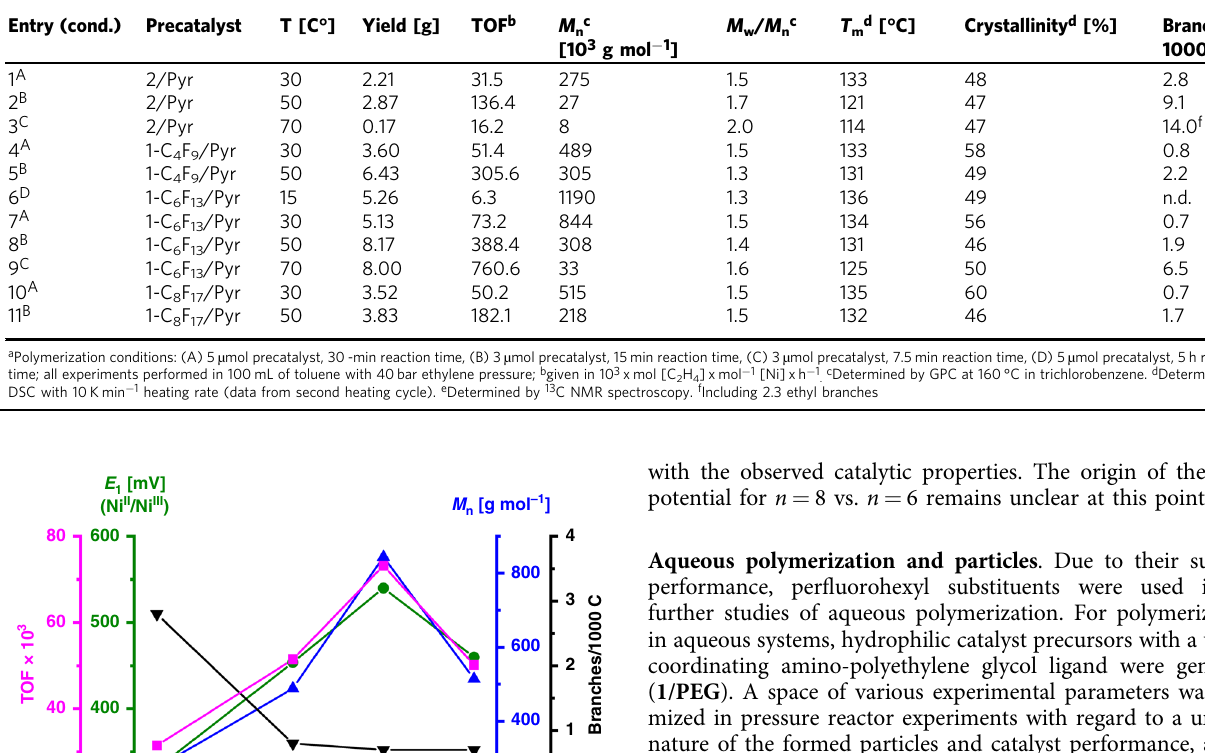
Table 1 Ethylene polymerization results in toluene a